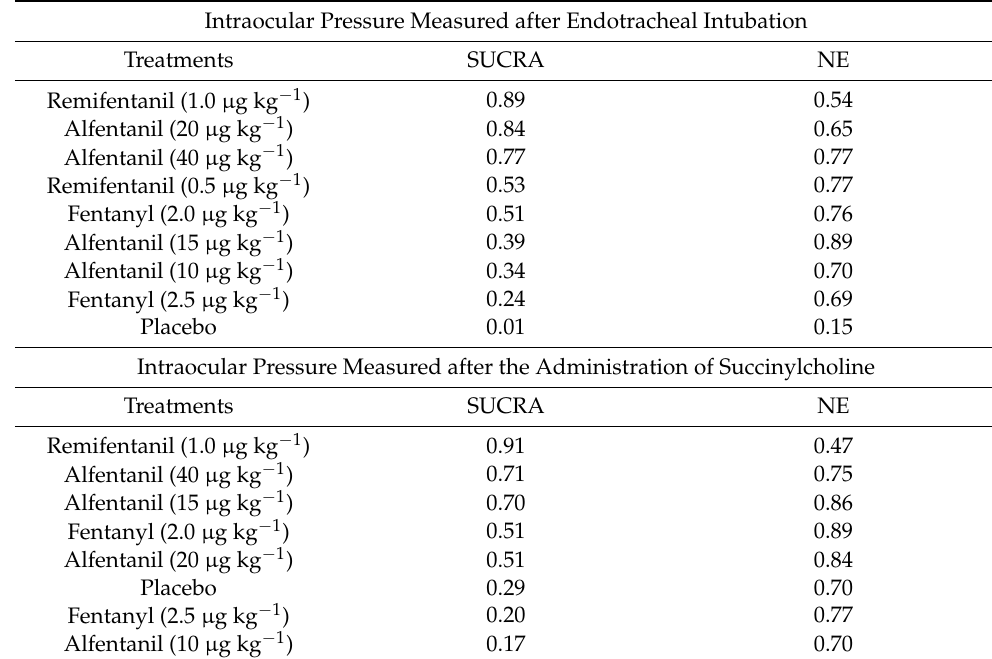
Table 3. The surface under the cumulative ranking curve (SUCRA) and normalized entropy (NE) of each